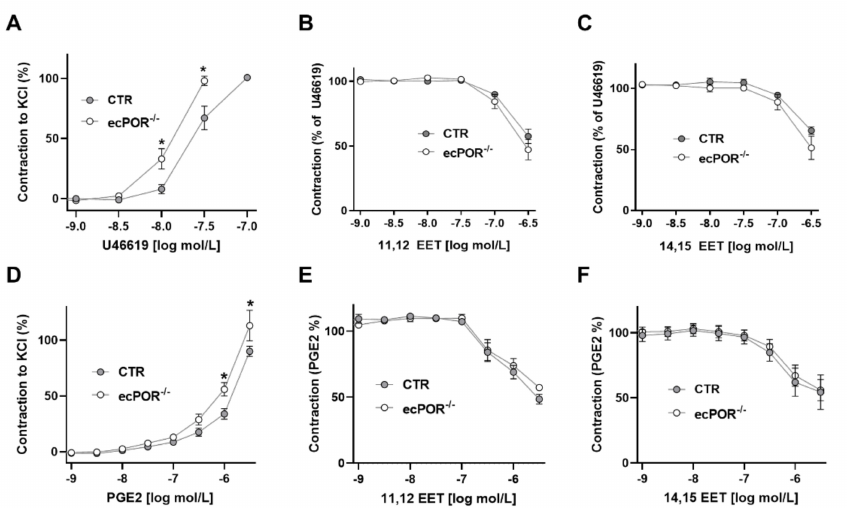
Figure 3. Knockout of POR in the endothelium leads to increased constriction of the thromboxane re- ceptor agonist U46619 and PGE2 in aorta. Vasoconstriction of aortic vessels from CTR and ecPOR − / − mice in response to U46619 ( A ) and PGE2 ( D ) * p < 0.05, Two-way ANOVA with Bonferroni post-test. n > 11 aortic rings. ( B , E ) Vasodilation of aortic vessels from CTR and ecPOR − / − mice following 11,12-EET treatment after preconstriction with U46619 ( B ) and PGE2 ( E ). Two-way ANOVA with Bonferroni post-test. n ≥ 7 aortic rings. Vasodilation of aortic vessels from CTR and ecPOR − / − mice in response to 14,15-EET after preconstriction with U46619 ( C ) and PGE2 ( F ). Two-way ANOVA with Bonferroni post-test ( C ) n = 4 and ( D ) n = 5 aortic rings. In comparison to phenylephrine and KCl, the constriction induced by U46619 is largely mediated by RhoA-dependent kinase activation and light chain phosphatase inhibition [17]. Given that EETs have been linked to the RhoA-system, the effect of RhoA-dependent